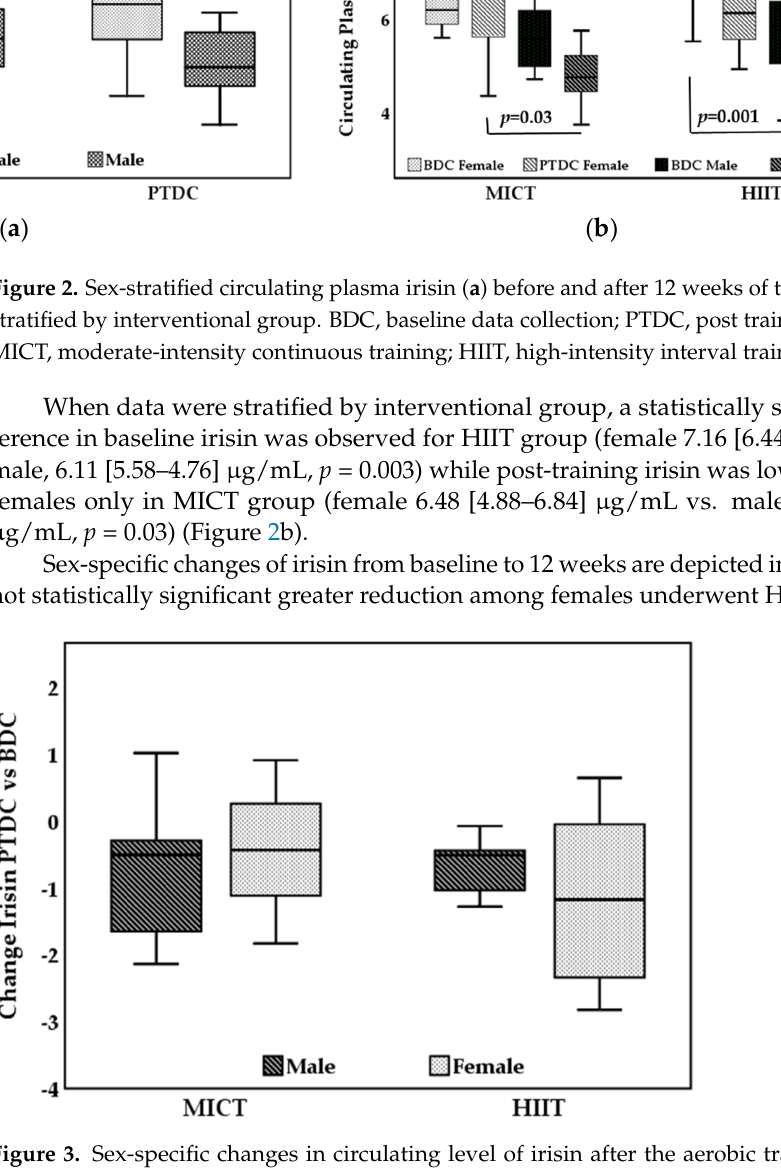
6 of 11 Figure 1. Changes in circulating level of irisin after the aerobic training of 12 weeks: MICT and HIIT groups. BDC, baseline data collection; PTDC, post training data collection; MICT, moderate-inten- sity continuous training; HIIT, high-intensity interval training.